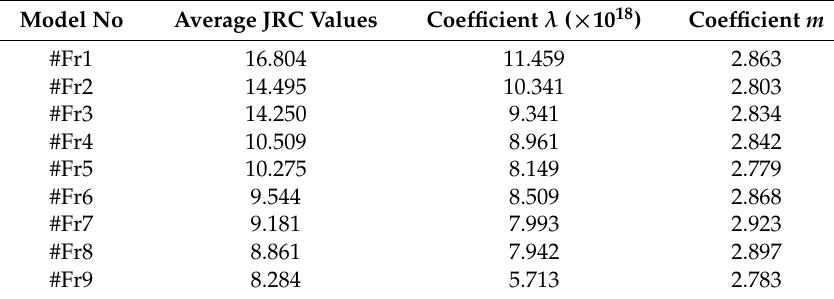
Table 2. Best-fitted coefficients λ and m using Equation (12).